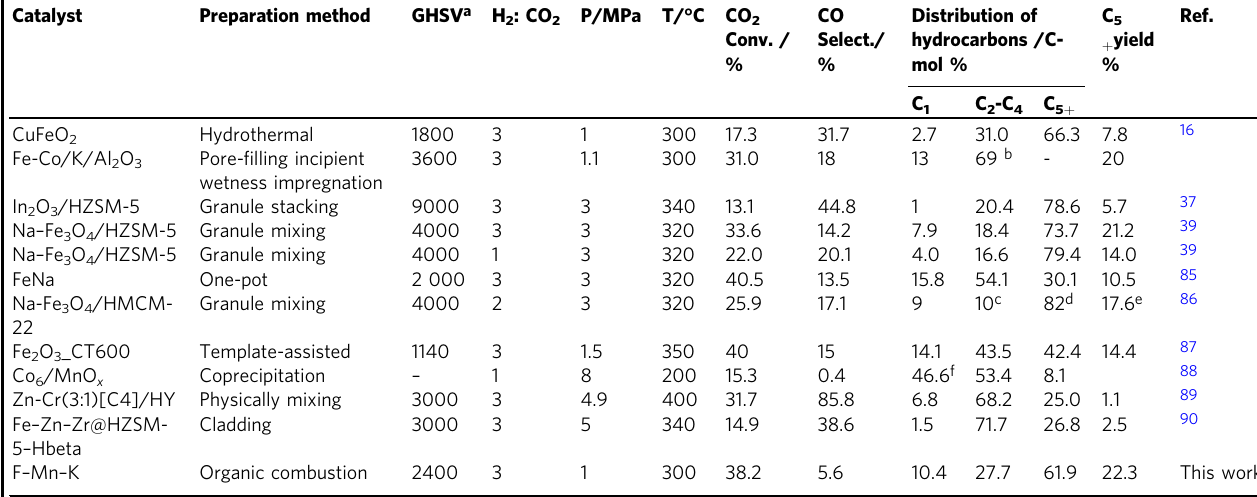
Table 1 Some typical catalysts performance for the direct conversion of CO 2 into hydrocarbon fuels; a brief literature